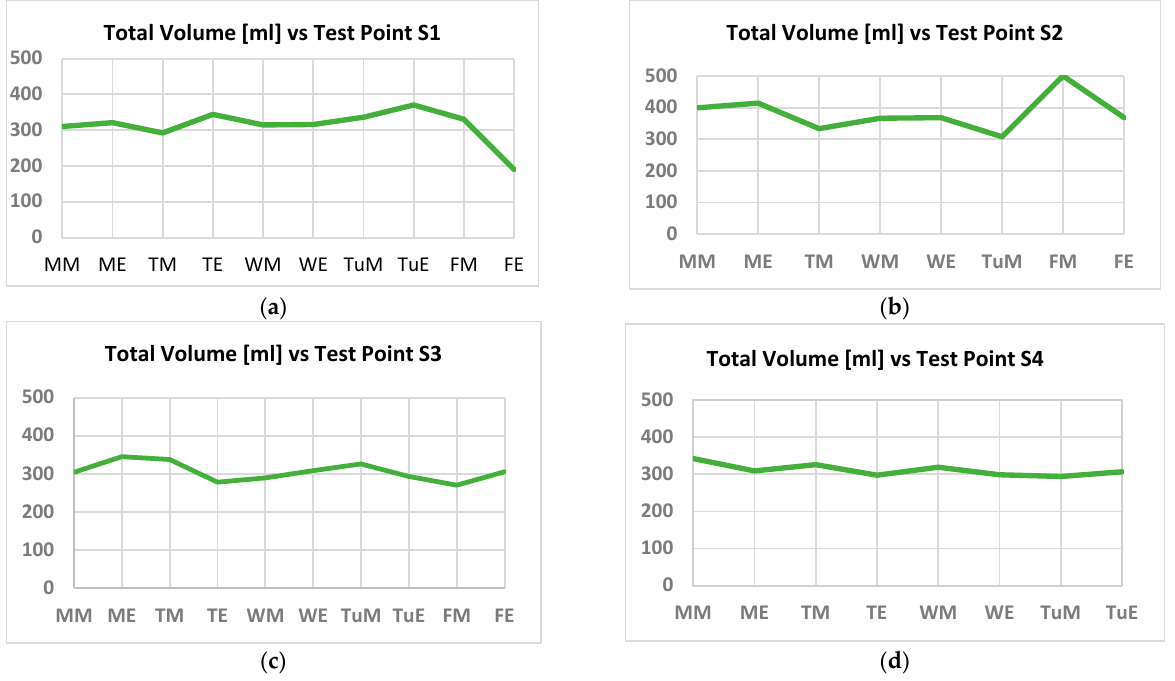
Figure 8. Volume estimated for healthy subjects versus test point. Table 1. Baseline characteristics of groups in the study.